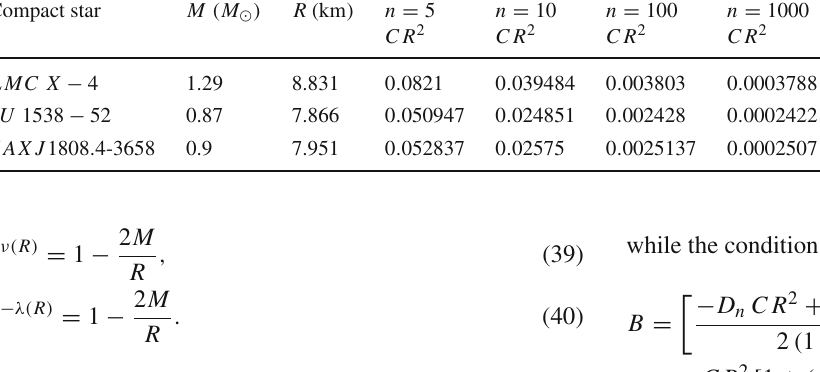
Table 2 Numerical values of physical parameters for the compact stars for different values of n Compact